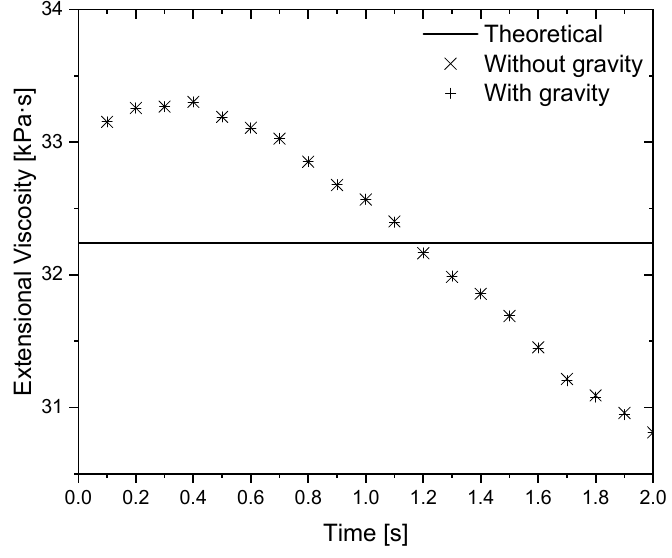
Figure 10. Effect of gravity on the numerical results of extensional viscosity.